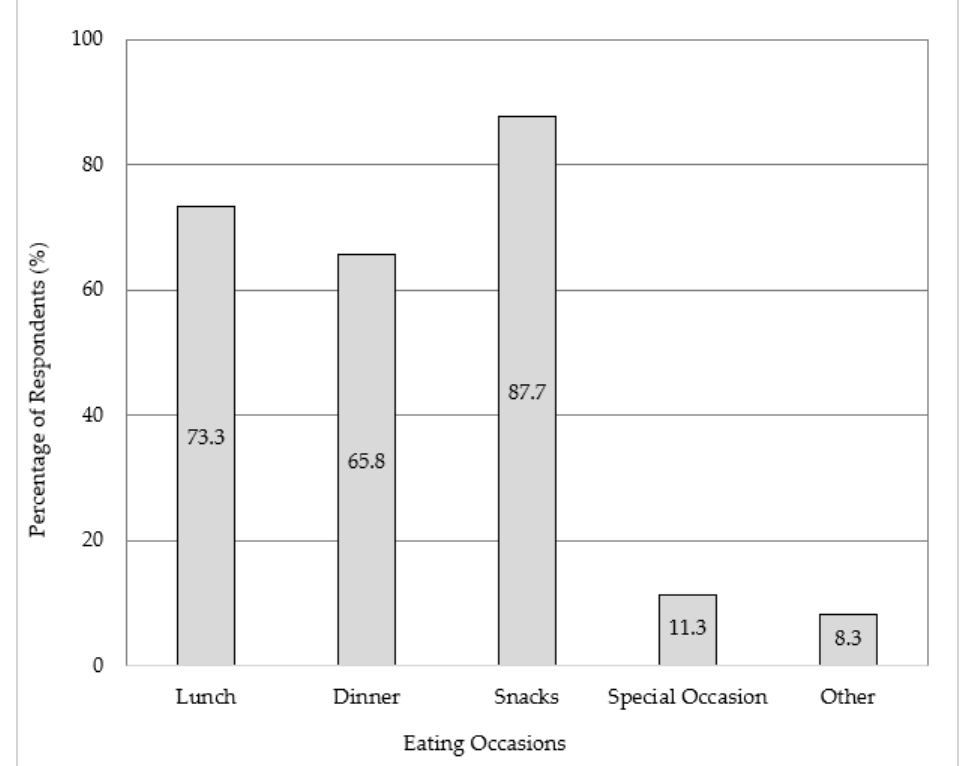
Figure 3. Popularity of seaweed consumption across eating occasions ( n = 1402). The eating occasions are presented in the figure in the way that they appear in the survey question. The data labels are representative of the percentage of participants that responded to each eating occasion.